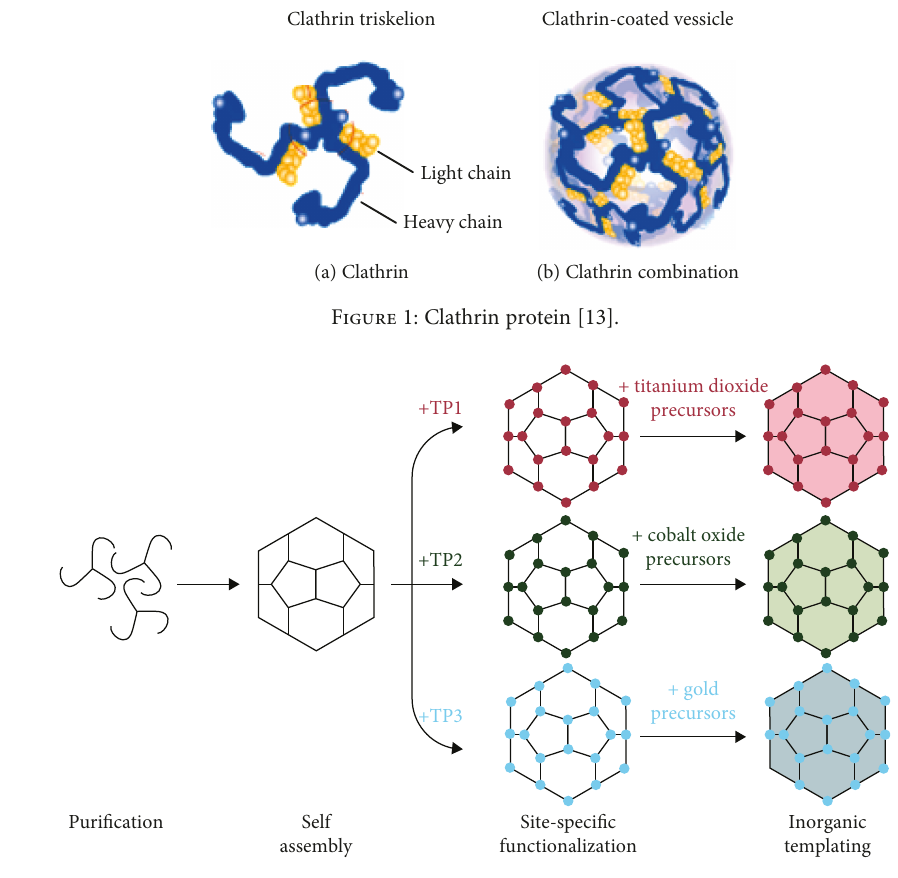
Figure 2: Application of clathrin on various materials [15].